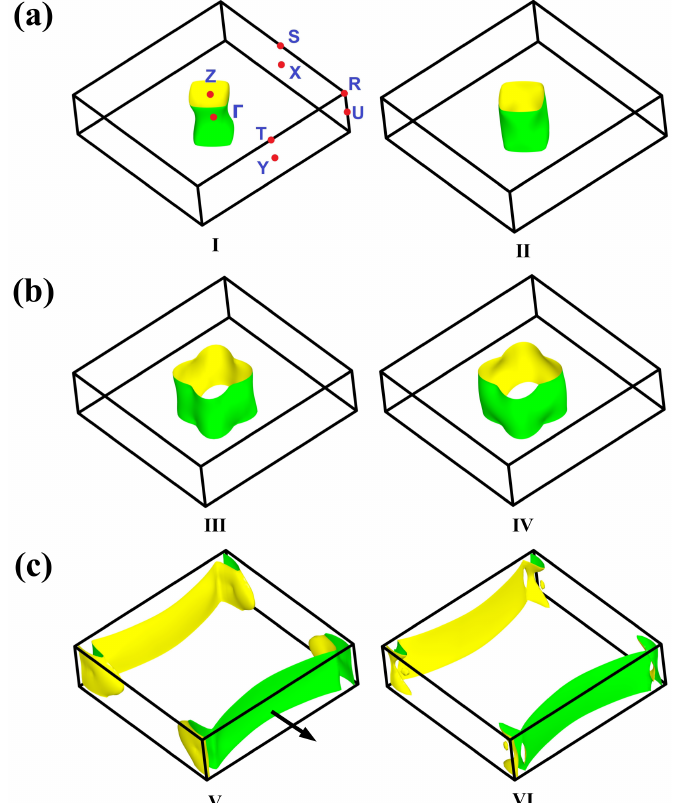
Figure 16. Fermi surface sheets in the AFM (antiferromagnetic) state of CeAgAs 2 calculated within the LSDA+U (local spin density approximation) approach (U = 6 eV). The sheets of similar shapes (originated from the pairs of succeeding conduction bands numbered by increasing Roman numerals with increasing their energy) are displayed in panels ( a – c ). High-symmetry points in the first BZ (Brillouin zone) are highlighted in panel ( a ). The black thick arrow in panel ( c ) indicates the direction of the quantization axis [100] for the AFM